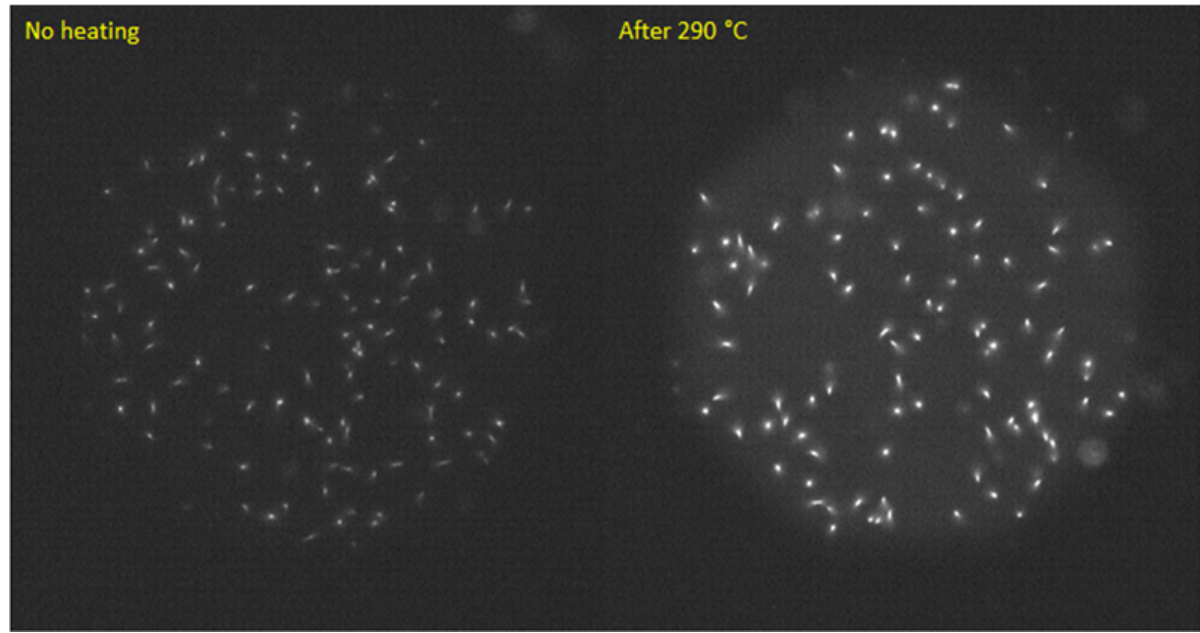
Figure 10. Microscopic fluorescent images registered with the same LiF crystal (acquisition time 2 s) before and after heat treatment at 290 °C. The sample was irradiated with Am ‐ 241 source (particle fluence around 1.60 × 10 6 cm − 2 ). The increase in the track intensity is about 2.5 times.